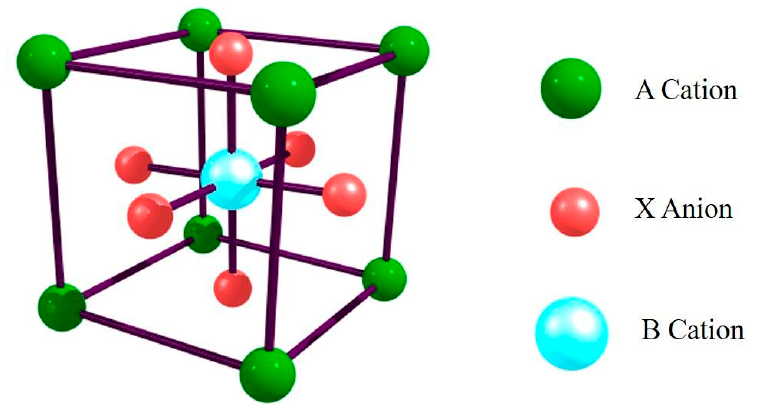
Figure 2. Undistorted cubic structure of perovskites with general formula ABX 3 .